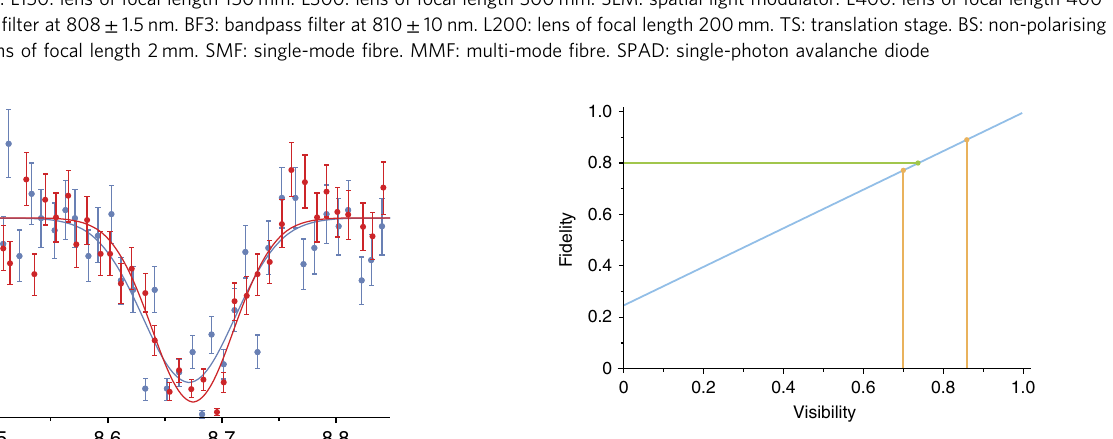
Fig. 6 Fidelity vs. visibility. Fidelity of the predicted state with the ideal states as a function of HOM visibility for the ‘ ¼ ± 1 subspace. The green point corresponds to the measured fi delity (0.80 ± 0.02); the orange points Fig. 5 Hong – Ou – Mandel (HOM) interference. HOM dips for photons in the correspond to the measured four-way HOM visibility of the data in Fig. 5 OAM ‘ ¼ ± 1 subspace. The red points show data when the photons in (0.86 ± 0.04 and 0.70 ± 0.05). The blue line corresponds to the paths B and C are both in the mode 1 j i ; the blue points show data when the p 1 j i þ (cid:2) 1 j ið Þ . We fi t a photons in paths B and C are both in the mode 1 ffiffi 2 Gaussian curve with a visibility of 0.86 ± 0.04 and 0.70 ± 0.05, respectively. The error bars correspond to the standard deviation of the count rate assuming Poisson statistics, and these data are background- subtracted